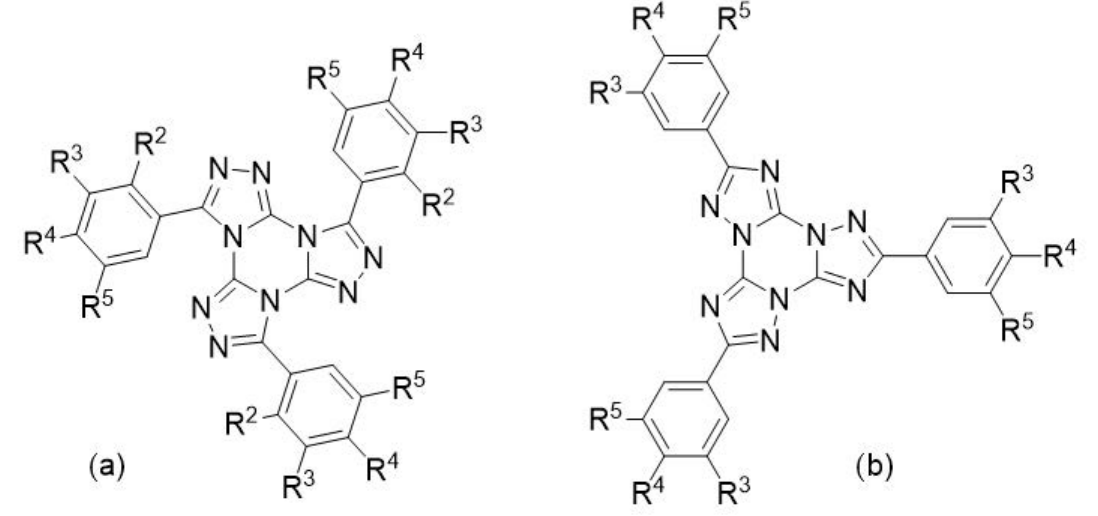
Figure 1. Tangential tristriazolotriazines ( t -TTTs) ( a ) and propeller tristriazolotriazines ( r -TTTs) ( b ) and the substitution